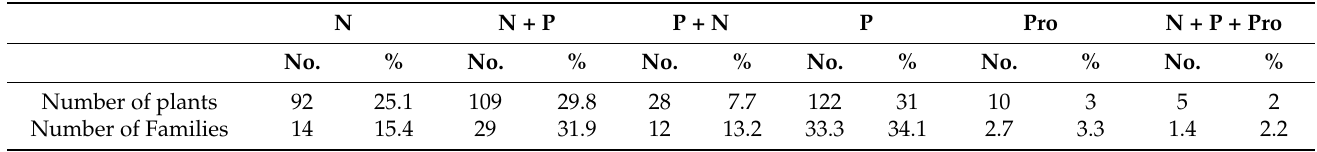
Table 1. Number of plant species and families benefiting the bees in Al-Baha region, southwestern Saudi Arabia.